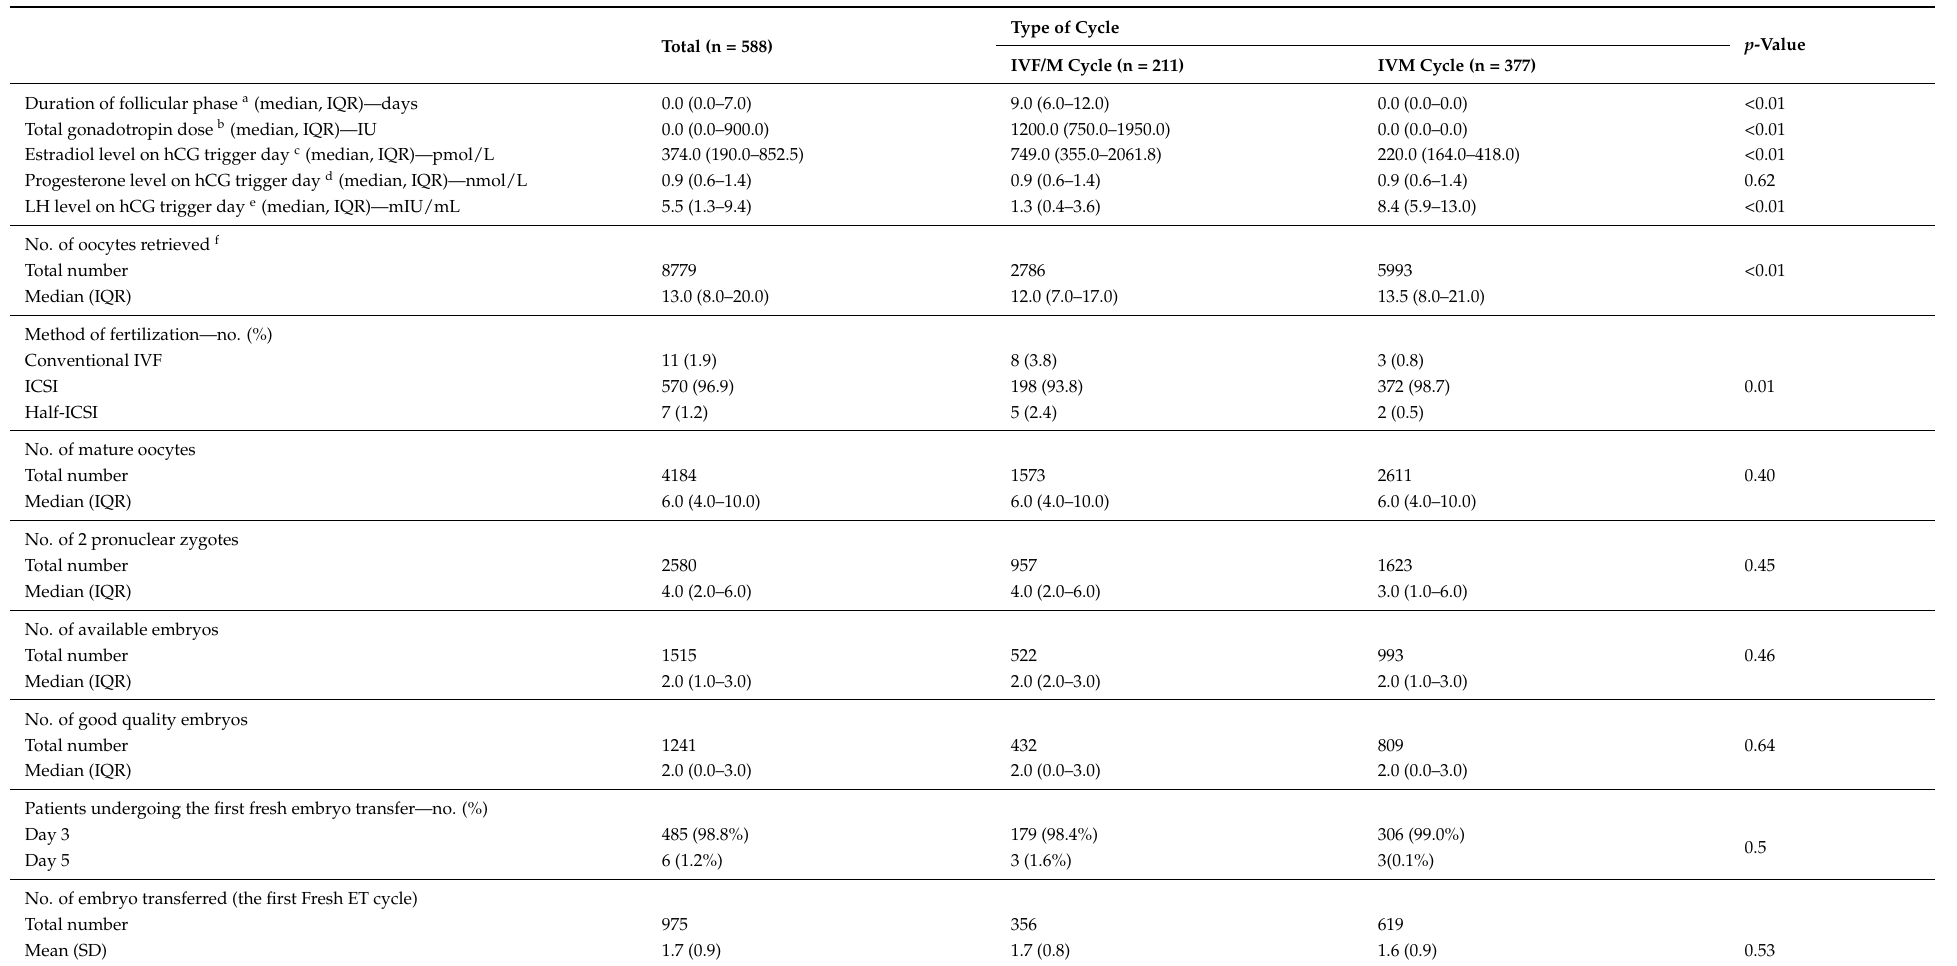
Table 3. Treatment and laboratory outcomes of participants, by the natural or stimulation